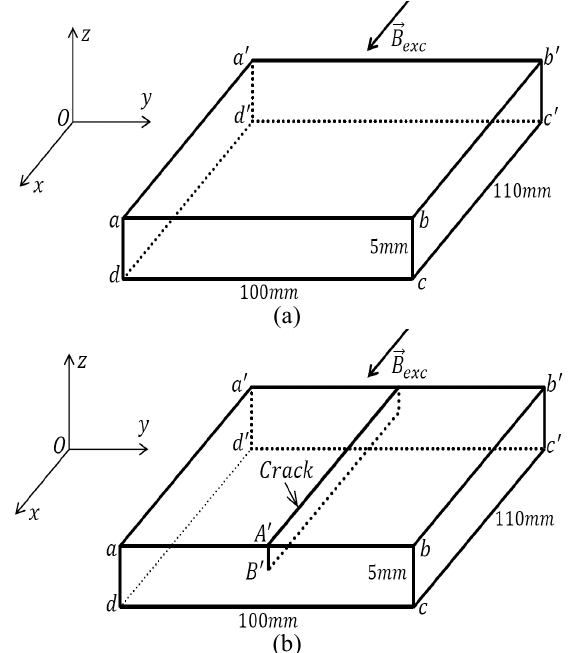
Figure 1: Description of a flawless plate (a) and a